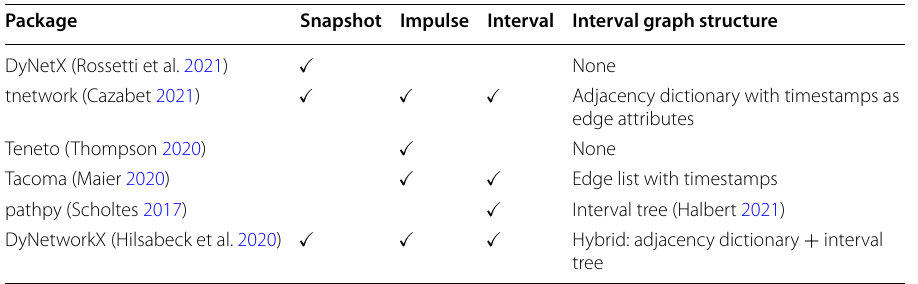
Check marks represent package’s ability to store a temporal network using the corresponding representation. Interval implementation gives a brief description of the data structure used to store interval graphs